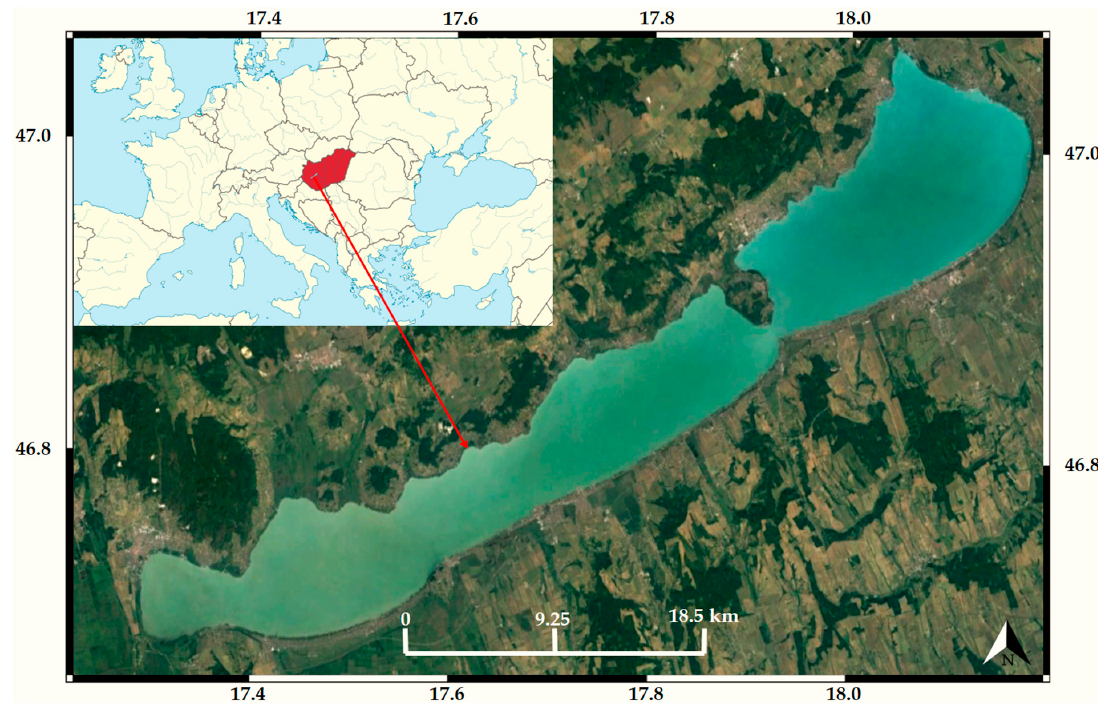
Figure 1. Location of the study area, based on [55].